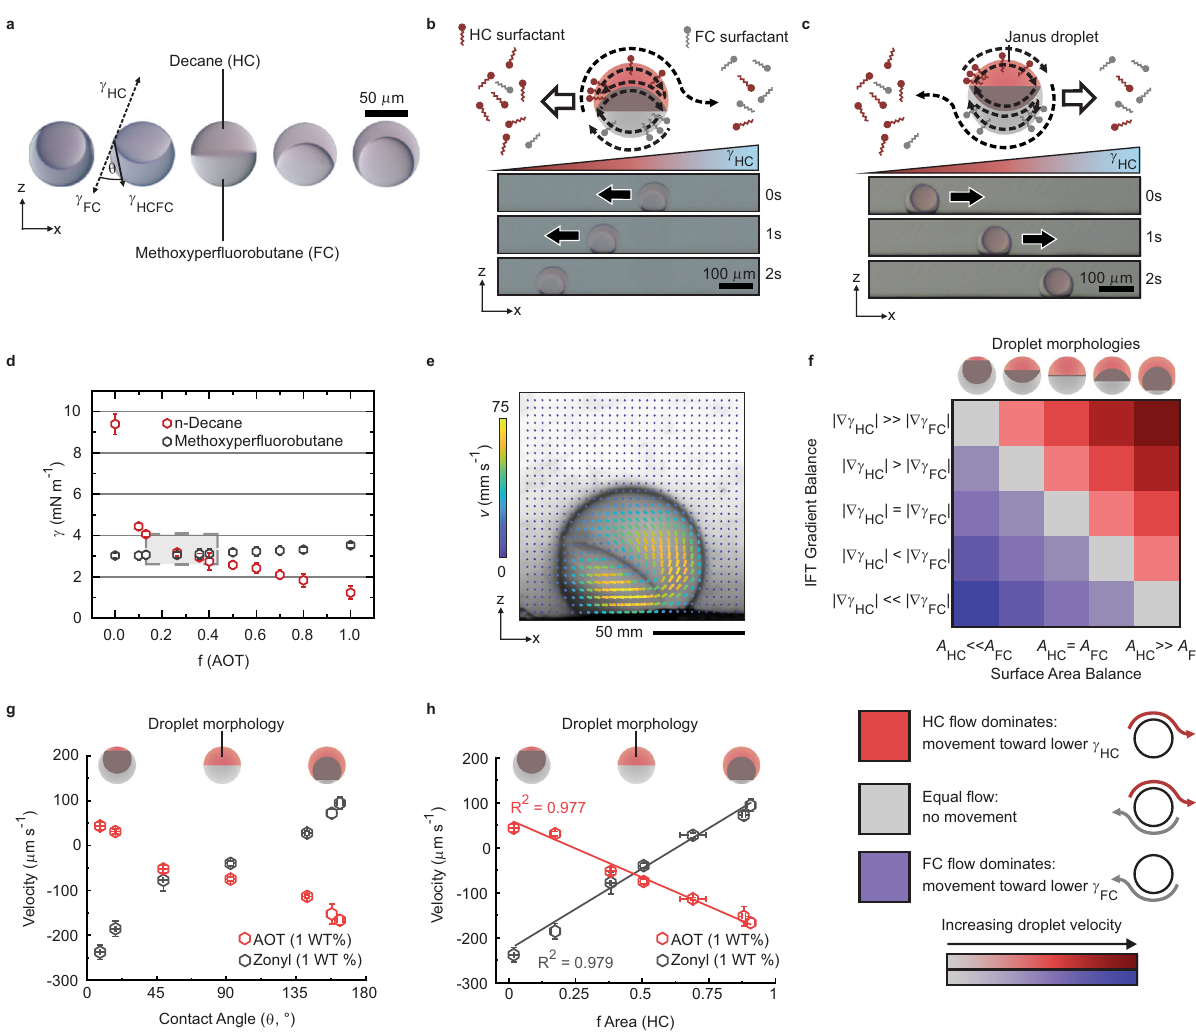
Fig. 2 Reversible morphology-resolved chemotaxis of Janus emulsion droplets inside a laminar surfactant gradient. a Side-view micrographs of Janus emulsion droplets in three different morphologies; the contact angle at the triple phase contact line is used to quantitatively describe the various Janus emulsion morphologies; b schematic illustration of the anisotropic Marangoni-type fl uid fl ows surrounding a Janus droplet ( θ = 155°) inside a laminar surfactant gradient; side-view time-sequence micrographs of the Janus droplet moving toward the region where 1 wt.% of a pure AOT solution was added; c corresponding sketch and side-view time-sequence micrographs of the same Janus droplets in a different morphology ( θ = 25°) displaying movement away from the region where 1 wt.% AOT was added; d pendant drop tensiometry measurements of the individual droplet phases inside a 1 wt.% aqueous surfactant solution comprised of AOT and Zonyl in varying fractions, with the inset box re fl ection the region of dynamic droplet morphology recon fi gurability; e particle image velocimetry (PIV) of fl ow fi elds surrounding Janus droplets in a hydrocarbon-dominant morphology responding to the addition of 1:9 AOT:Zonyl (Supplementary Movie 3); f conceptual sketch of the expected droplet chemotactic behavior based on a combination of the two independent factors, the respective interfacial tension (IFT) differentials across the two droplet interfaces and the droplet morpohology; g morphology- dependent droplet velocities of Janus droplets moving in response to the addition of a 1 wt.% AOT and 1 wt.% Zonyl solution, respectively. A positive velocity notes movement away from the added surfactant, negative velocity notes movement toward the added surfactant; error bars re fl ect n ≥ 5 measurements; h measured chemotactic droplet velocities in response to the addition of Zonyl and AOT plotted as a function of the HC surface area